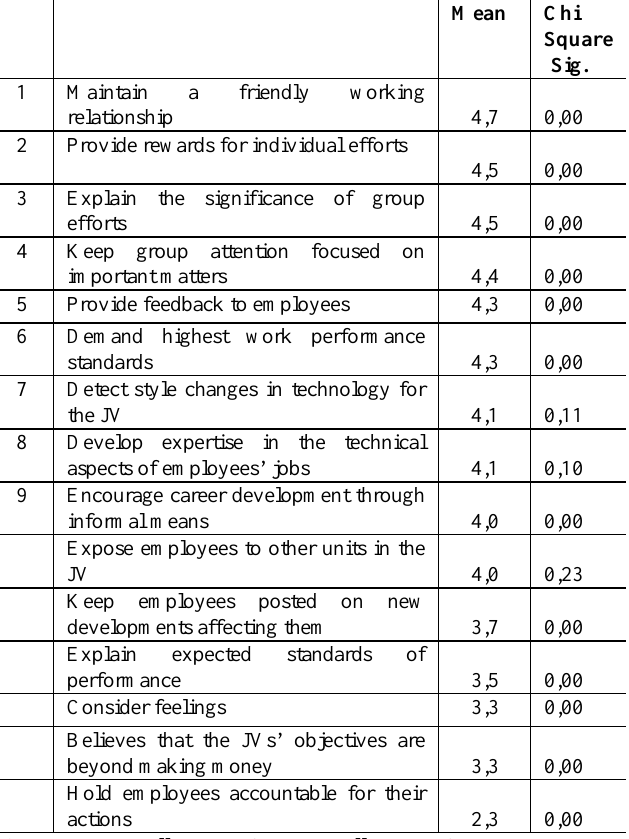
Table 6: Ideal US managers for South African-US